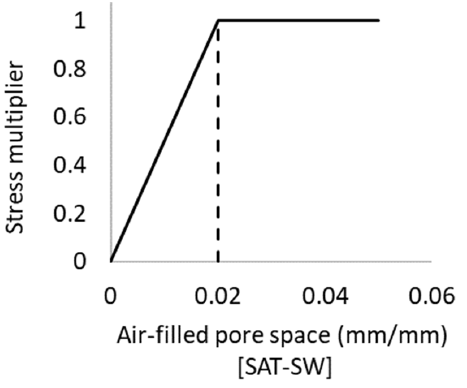
Figure 2. Function describing excessive moisture effects on the rate of root growth with an inflection point (threshold value) of